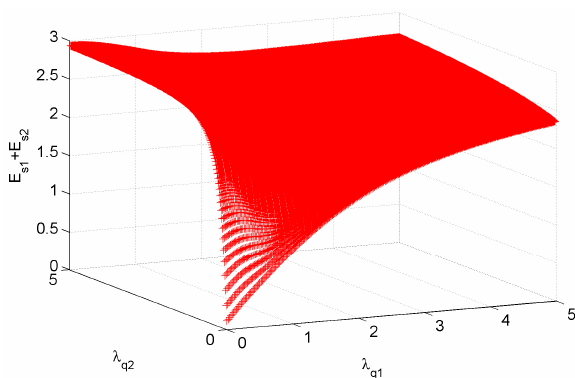
Figure 6. The range of p when λ q 1 and λ q 2 are similar.